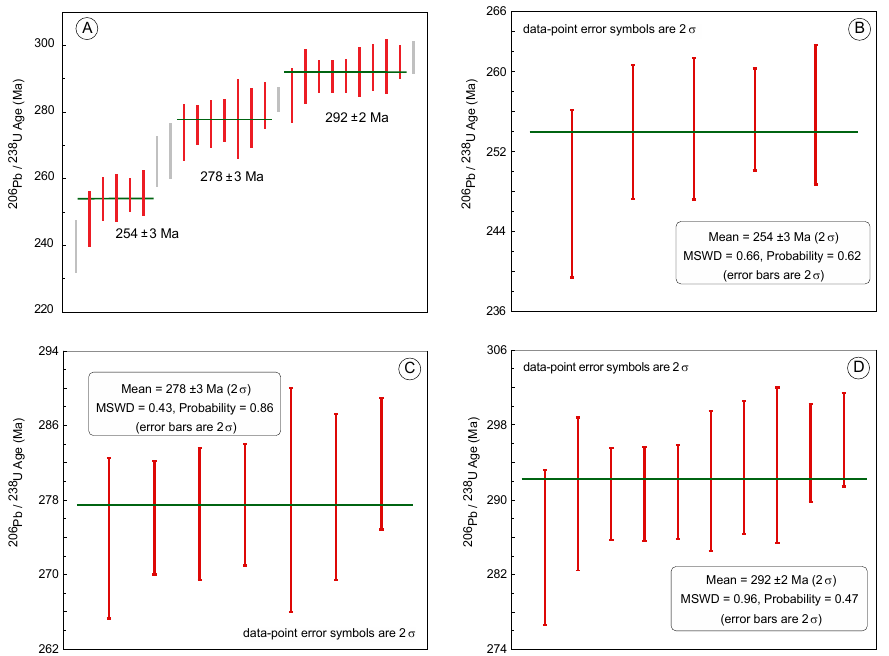
Figure 7. ( A ) Weighted mean ages of the Permian zircon populations of the integrated age distribution of both analyzed quartzites; ( B – D ) weighted mean ages of the integrated youngest zircon populations. Finally, a well-defined Middle Ordovician detrital zircon population (460–465 Ma)